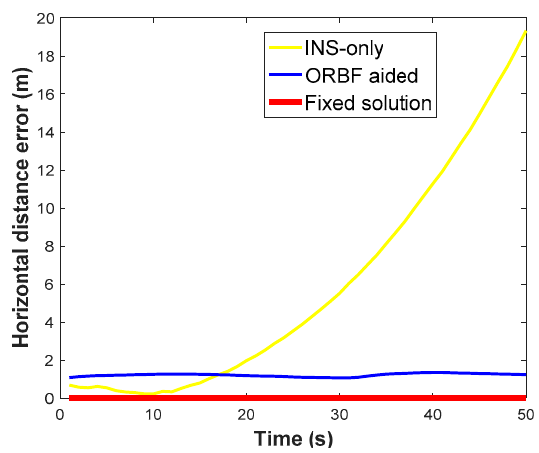
Figure 21. Horizontal distance error of with three strategies during GPS/BDS outage.